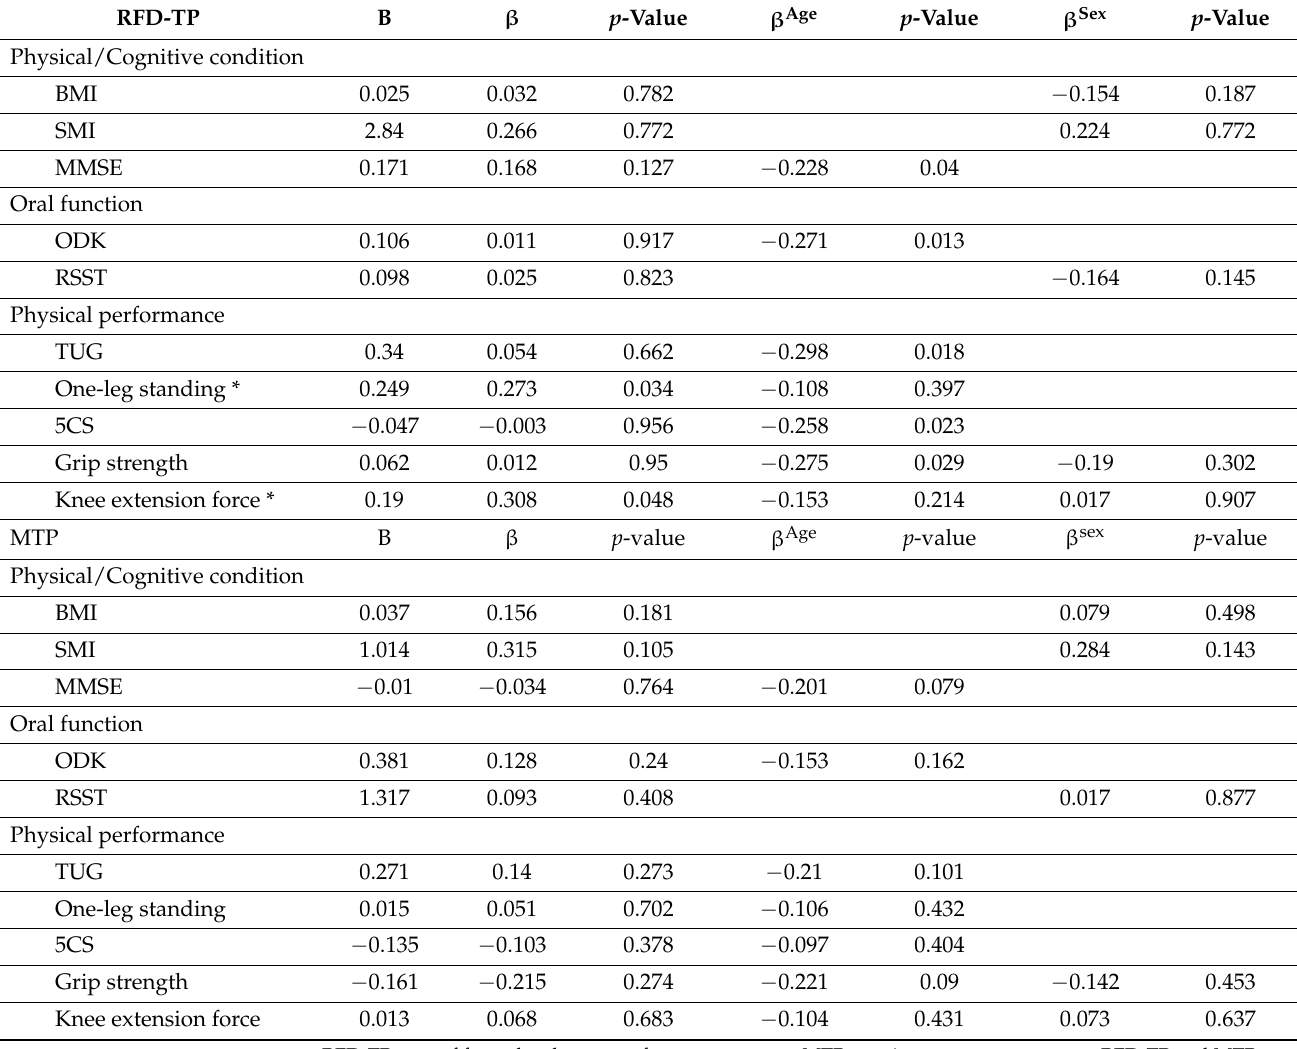
Table 3. Association of RFD or MTP with oral/physical performance.